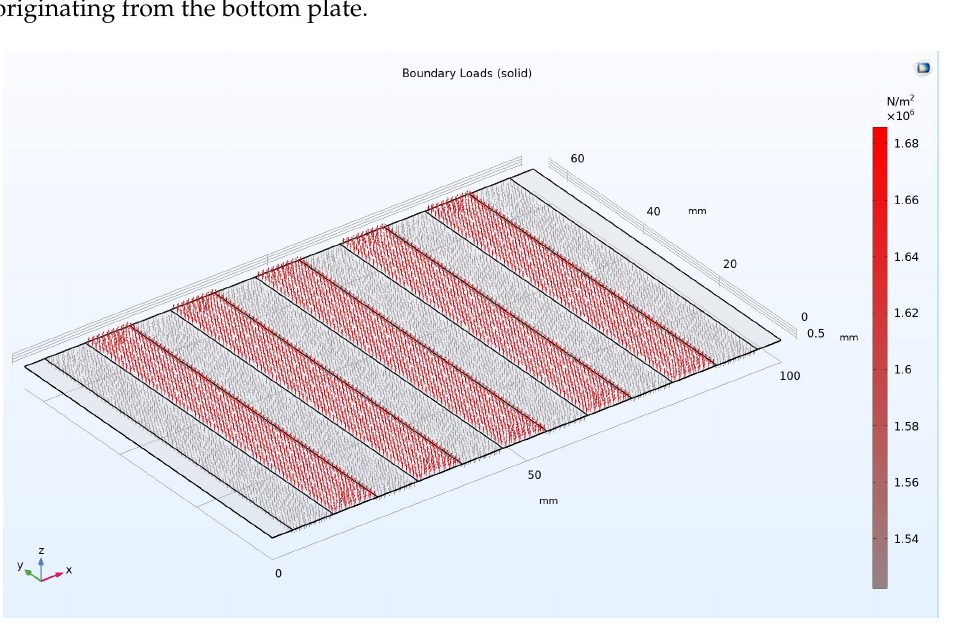
Figure 8. Boundary load simulation on COMSOL ®.